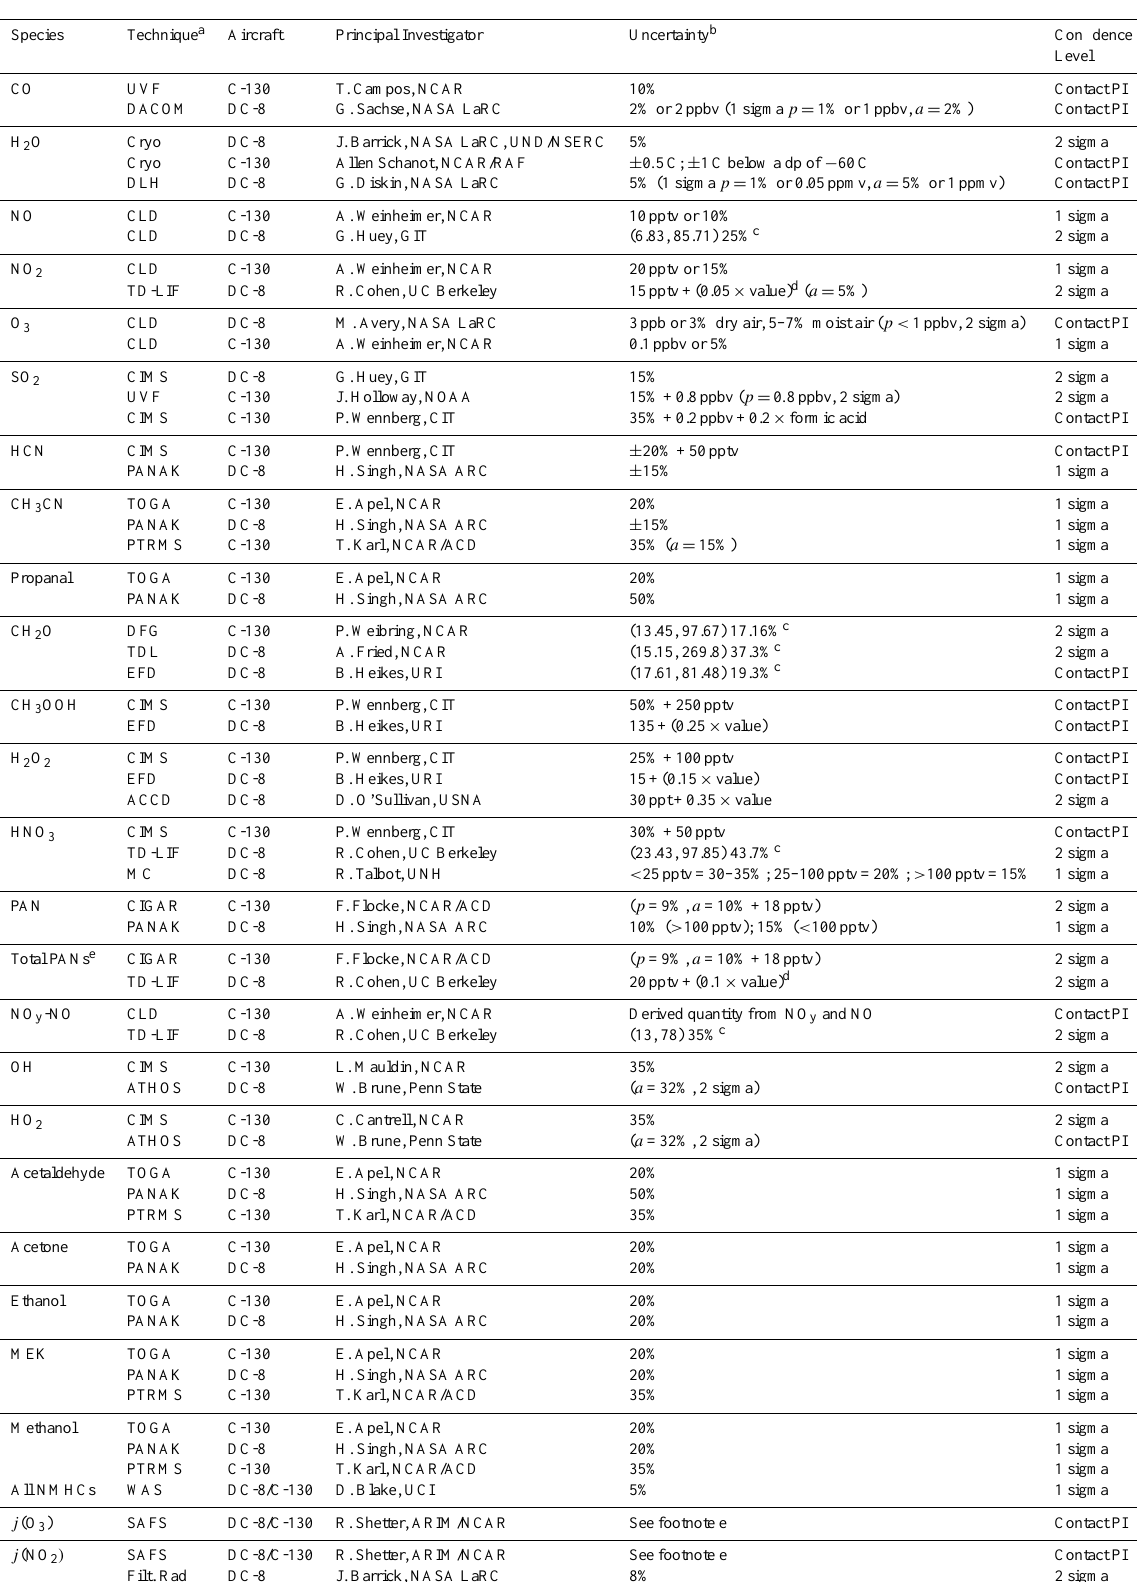
Table 2. Summary of Intercomparison Measurements. Species Confidence